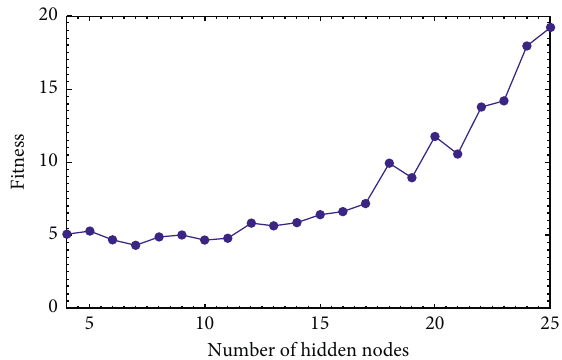
Figure 8: Fitness versus number of hidden nodes in the